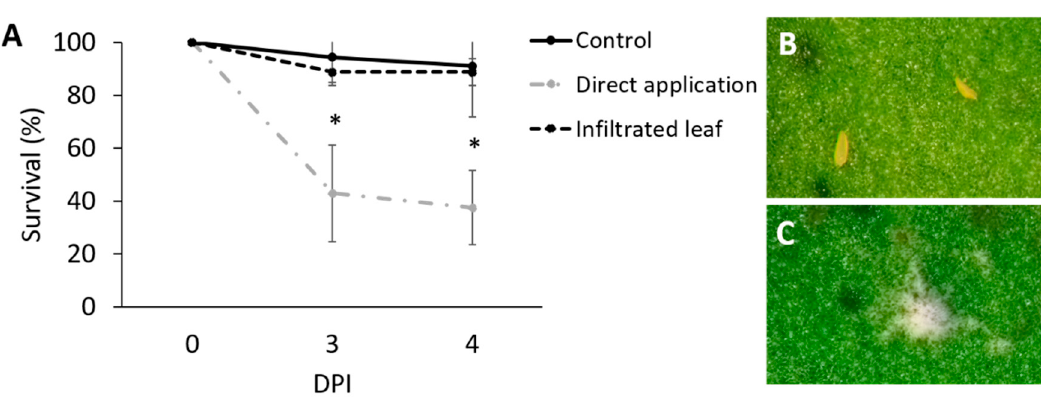
Figure 5. Assessment of Mb7 effect on Phyllocoptruta oleivora by leaf disc assay. ( A ) Survival of adult P. oleivora after direct exposure to Mb7 conidia (10 7 conidia mL − 1 ) and exposure to infiltrated leaves by 0.1 mL (10 7 conidia mL − 1 ). * Significant difference (DF = 8, F = 15.4, p < 0.0001). ( B ) Mites in the control group. ( C ) Mite cadaver from the direct-application group showing typical fungal infection. DPI, days post inoculation.